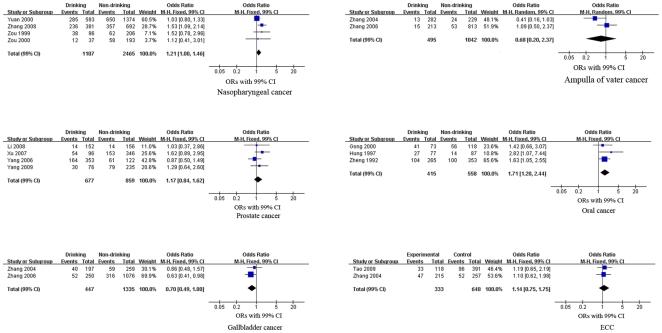
Forest plot of relative risk estimates of incident nasopharyngeal cancer, cancer of the ampulla of Vater, prostate cancer, oral cancer, gallbladder cancer and ECC by alcohol consumption in Chinese.This figure shows the forest plots for the meta-analysis of the association between alcohol consumption and the risk of nasopharyngeal cancer, cancer of the ampulla of Vater, prostate cancer, oral cancer, gallbladder cancer and ECC. OR and the 99% CI for each cancer was given.